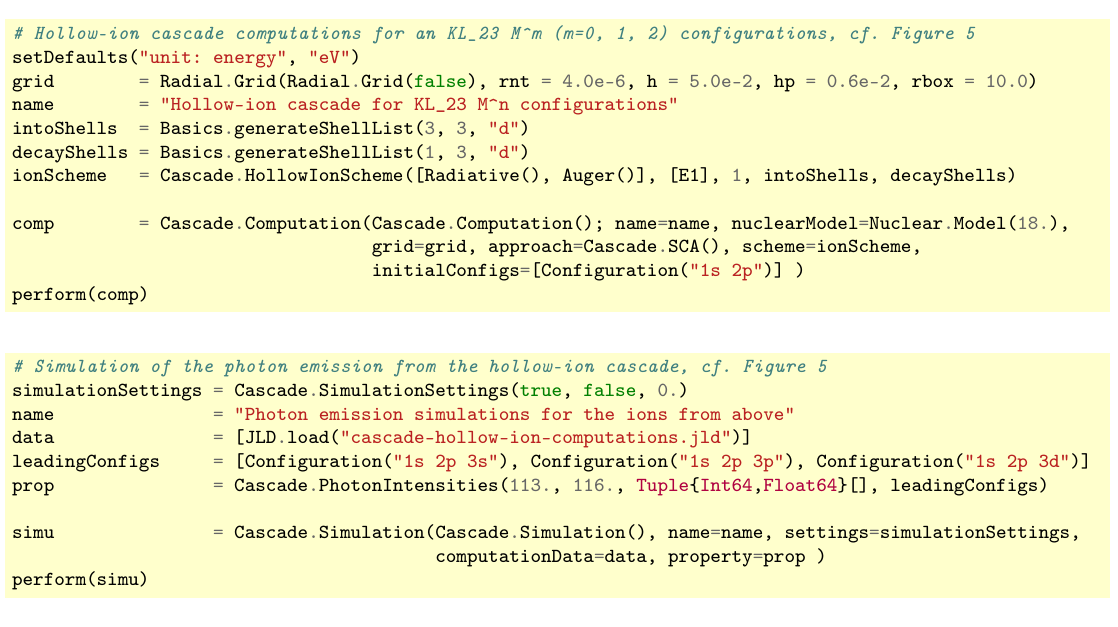
Figure 4. Julia input for generating the green spectrum in Figure 5 for an initial KL 23 M configuration of Ar 15 + ions; this input describes the cascade computation (upper panel) as well as the associated cascade simulation (lower panel). See text for further explanations. This figure also demonstrates how readily J AC can be employed in order to generate various spectra and properties. However, no attempt is made to explain this input in full detail, and for which we refer the reader to either the manual of the J AC toolbox [30] or the REPL [32].